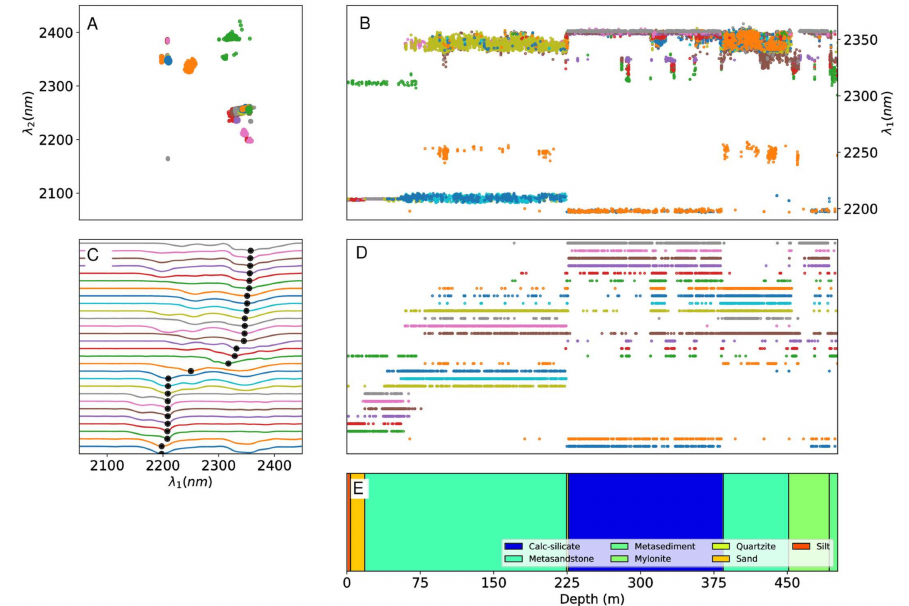
Figure 8. Using a hierarchical density-based clustering (HDBSCAN) clustering dimension of 3. The 1st and 2nd deepest wavelength location of the extracted features in the 2050–2450 nm spectral region of the MSDP13 dataset ( A ) and the down hole deepest feature as a function of hole depth ( B ). The ( C ) plot shows the calculated MSR assemblages for each of the clusters in the top-left while the ( D ) plot shows the down hole distribution of those assemblages and the ( E ) plot is the geologist’s logged litholgy. While a greater number of assemblages are observed and could be combined, the distribution plot middle-right reveals a greater amount of detail when compared to the geologist’s logged lithology